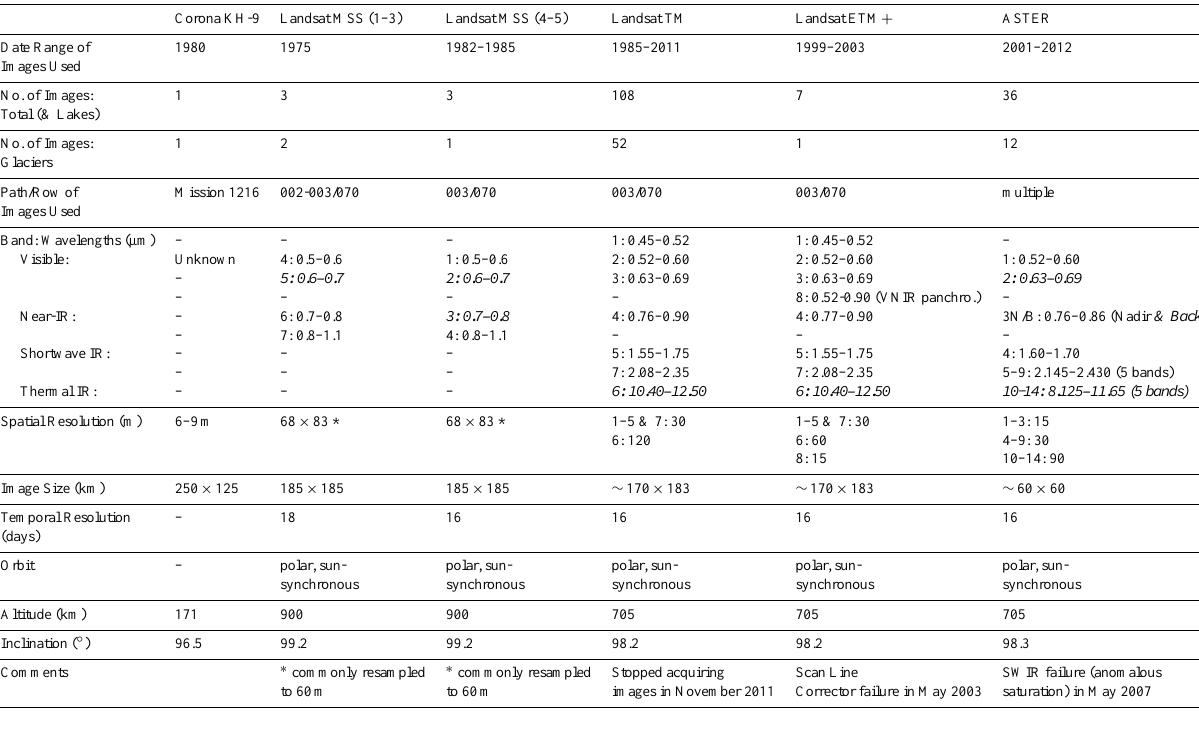
Table 1. Characteristics of the satellites and sensors used in this study. Bands in italics are those that have not been used. Data sources are as follows: Corona (Surazakov and Aizen, 2010), Landsat (http://landsat.gsfc.nasa.gov/about/technical.html), ASTER (http://asterweb.jpl.nasa. gov). Table modified after Svoboda and Paul (2009).